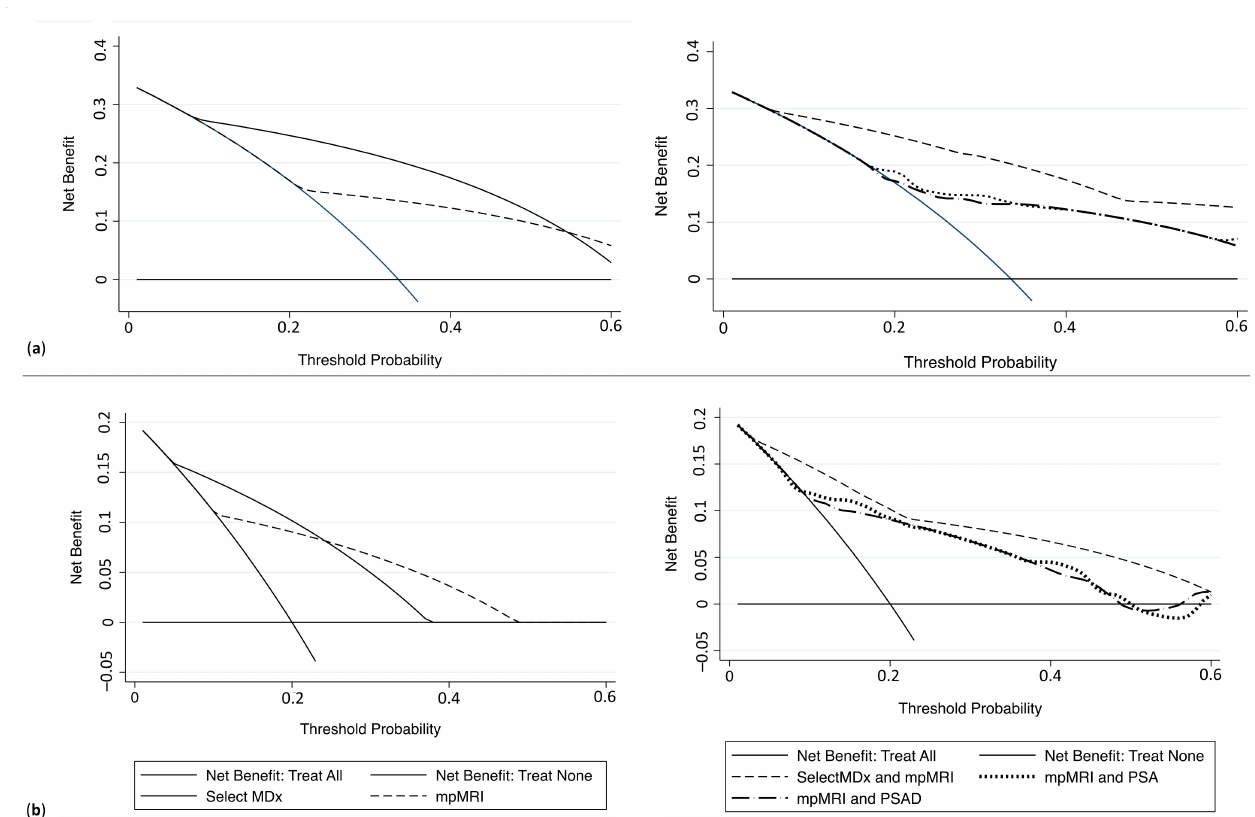
Figure 3. Decision curve analysis comparing clinical utility of SelectMDx score, mpMRI, and the associations mpMRI+ SelectMDx, mpMRI + PSA and mpMRI + PSAD for detecting ( a ) PCa and ( b ) csPCa. (mpMRI = multiparametric magnetic